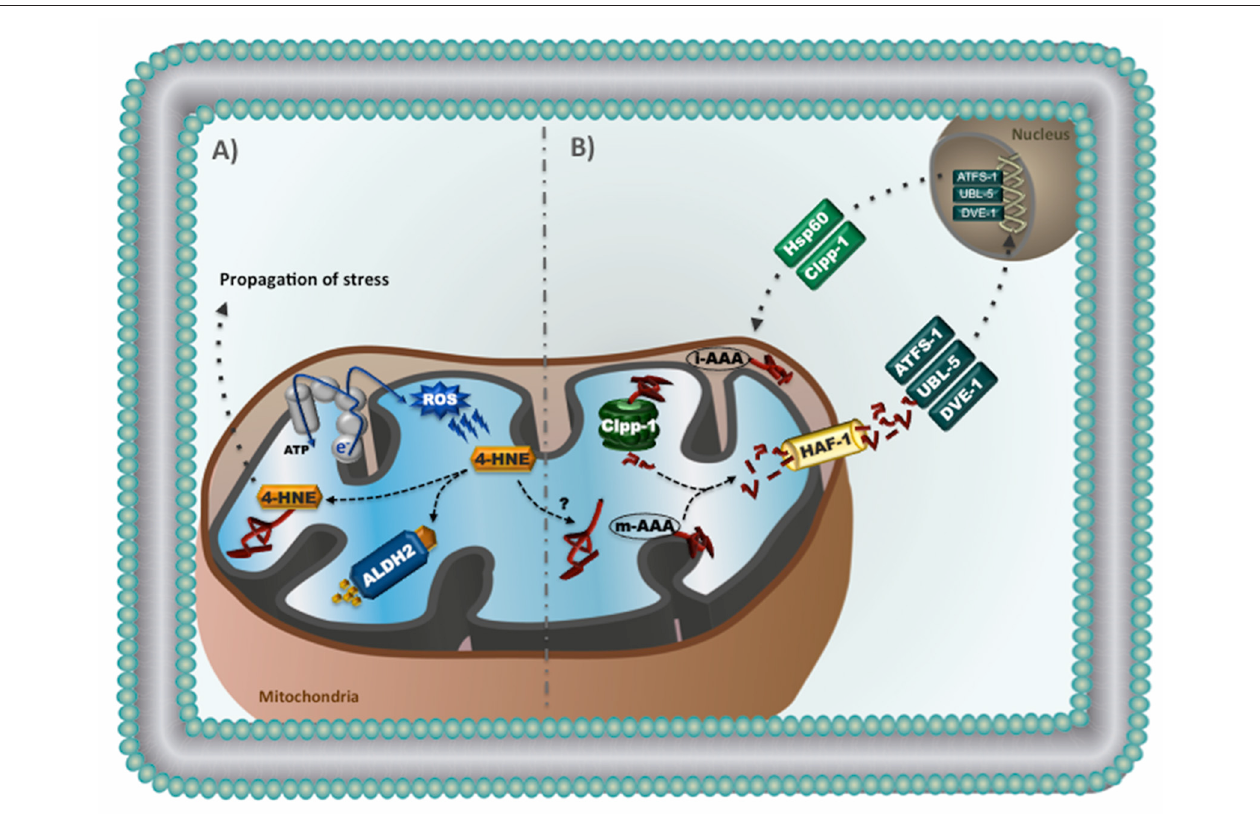
FIGURE 1 | (A) Reactive aldehydes in mitochondria: excessive reactive oxygen species causes lipid peroxidation and consequent generation of 4-hydroxynonenal (4-HNE), a highly reactive aldehyde that readily forms protein adducts. Accumulation of 4-HNE adducts causes mitochondrial dysfunction and contributes to the propagation of stress related to cardiac pathophysiology. Aldehyde dehydrogenase 2 (ALDH2) is a mitochondrial enzyme responsible for the conversion of 4-HNE into inactive acids. (B) Mitochondrial unfolded protein response (UPR mt ): Accumulation of mitochondrial unfolded proteins results in increased proteolysis and release of mitochondrial-generated peptides to the cytosol. It is suggested that these peptides activate cytosolic transcription factors (i.e., ATFS-1, UBL-5, and DVE-1). Once inside the nucleus, these transcription factors promote upregulation of genes involved in mitochondrial proteostasis (i.e., chaperones and proteases), thus relieving stress and re-establishing mitochondrial homeostasis. The UPR mt has been characterized in the nematode Caenorhabditis elegans .